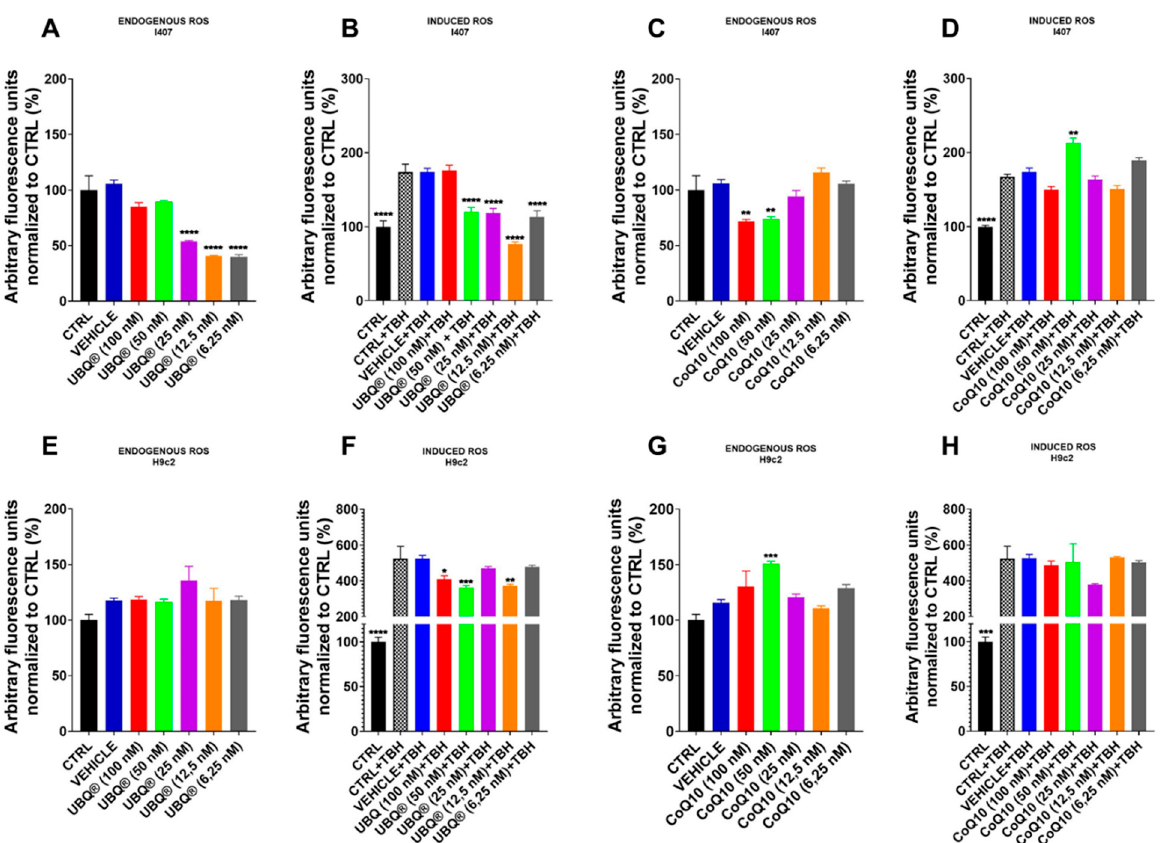
Figure 4. Oxidative stress determination in I407 and H9c2 cells. Cells were incubated with CoQ10 phytosome (UBQ), native CoQ10 (Q10) and phytosome (vehicle) at different concentrations for 24 h. Endogenous oxidative stress was measured in intact I407 ( A , C ) and H9c2 ( E , G ) cells using the fluorescent probe 2 ′ ,7 ′ -dichlorodihydrofluorescein diacetate (DCFDA). Oxidative stress was induced in intact I407 ( B , D ) and H9c2 ( F , H ) cells using 130 μ M of tert-butyl hydroperoxide (TBH). Data were normalized to protein content and presented as a percentage of untreated control fluorescence signal ( n = 48). For all panels, data are presented as the mean ± s.e.m, * p ≤ 0.05; ** p ≤ 0.01; *** p ≤ 0.001; **** p ≤ 0.0001. Statistical analysis was performed using one-way ANOVA followed by Tukey’s honest significant difference test.